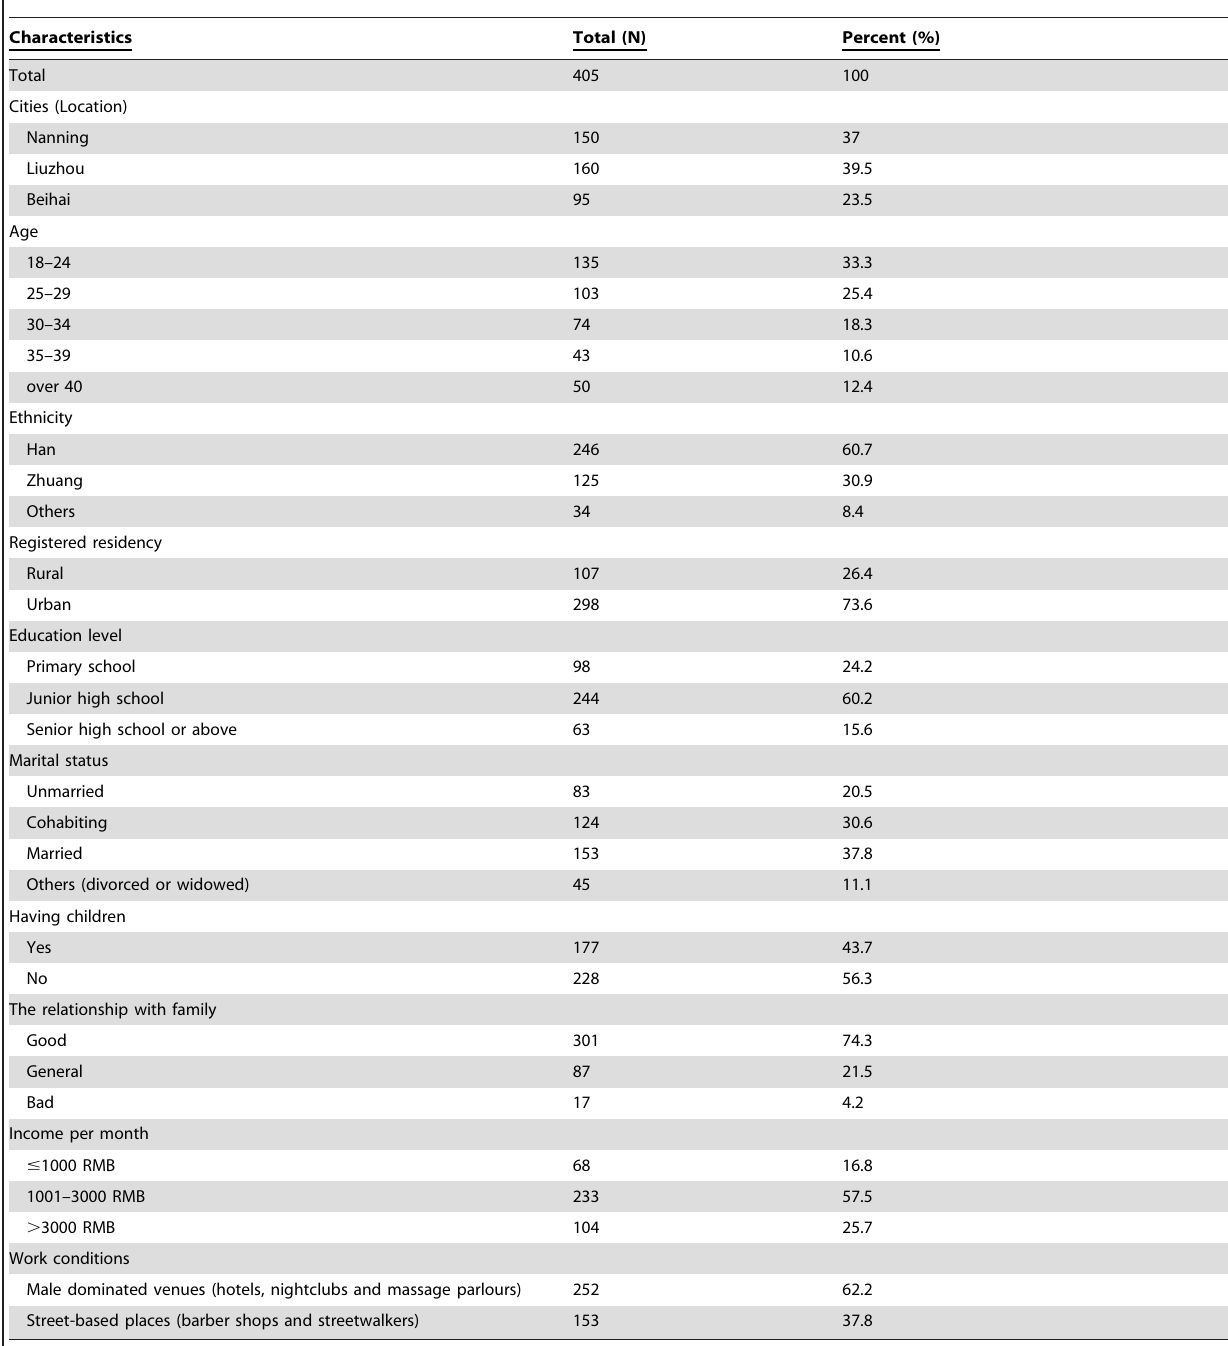
Table 1. Demographic characteristics of